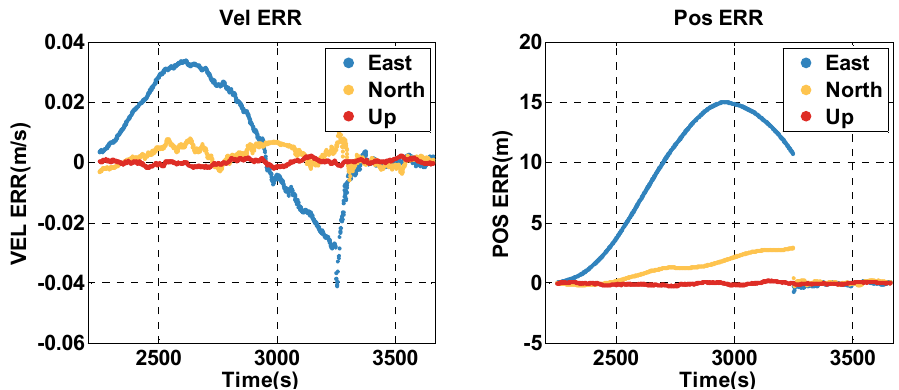
Figure 9. The position and velocity errors of the proposed MTF method in the satellite outage context.